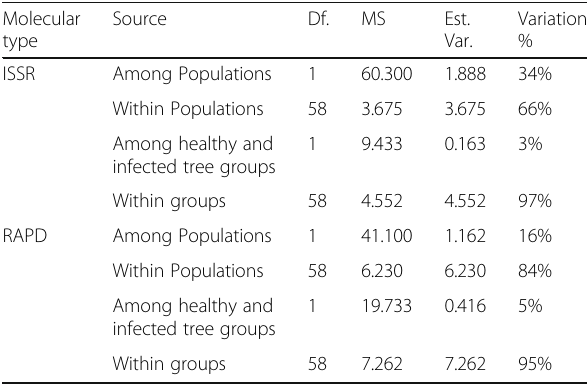
Table 5 Results of analysis of molecular variance (AMOVA) on the basis of ISSR and RAPD markers for the healthy and infected B. hyrcana trees originating from two populations in the Hyrcanian